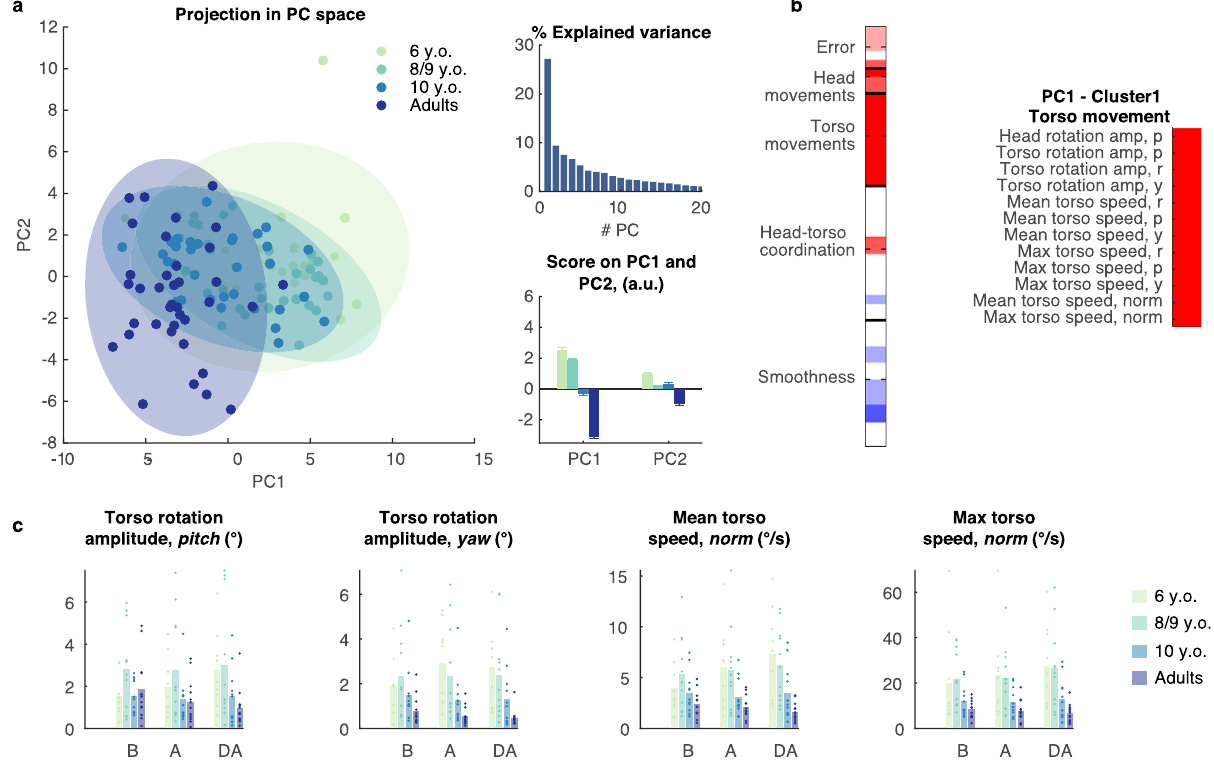
Figure 4. Torso involvement in head-controlled trials decreases with age. ( a ) PCA applied to the data collected on head-controlled trials. The projection of the data in the space spanned by the first two PCs displays an age- based separation along the first component (left) representing 27.2% of the overall variance (top right). Group means of the scores on the first two PCs (bottom right, mean + SEM). ( b ) Normalized loadings of the descriptive variables on the first PC (left) and variables with absolute loadings larger than 0.75 grouped into a functional cluster. ( c ) Representative variables selected from the functional cluster with significant effect of Age. Dots represent the average value for each individual participant, bars the average across participants. N = 9 (6 y.o.), 12 (8–9 y.o.), 11 (10 y.o.), 13 (adults). B: Before, A: After, DA: Day